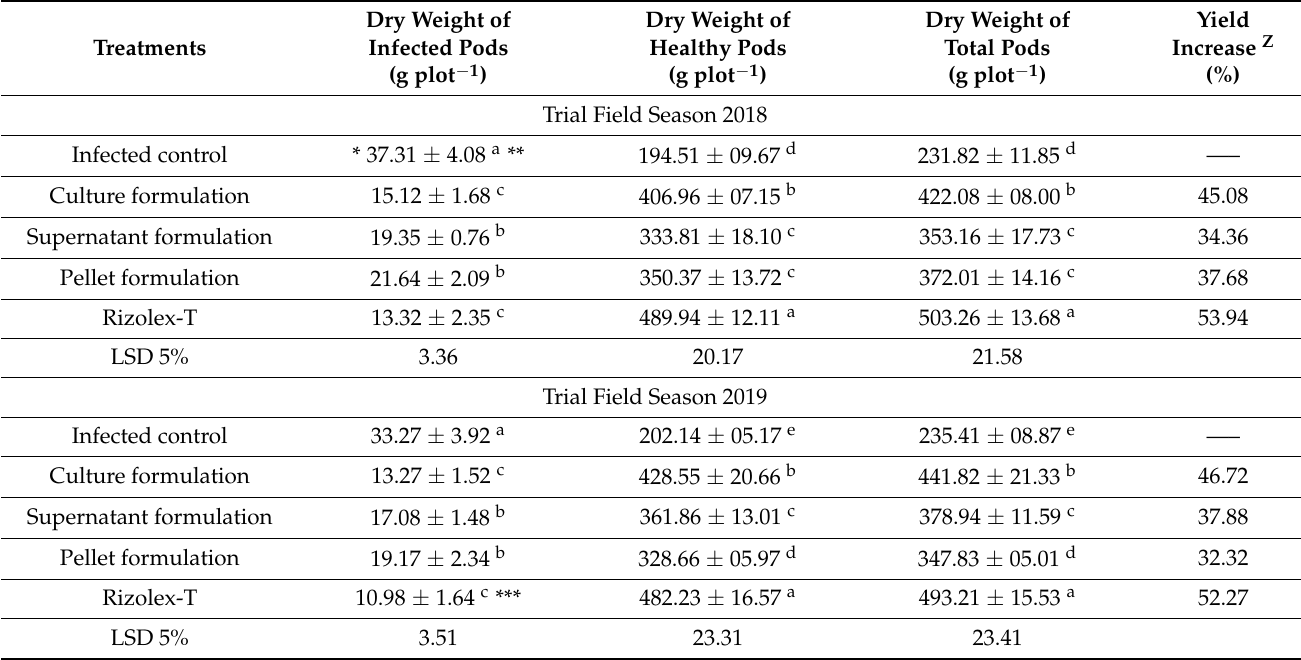
Table 8. Effect of treatment with talc-based formulations of Streptomyces cellulosae Actino 48 on peanut yield under open-field conditions during seasons of 2018 and 2019.